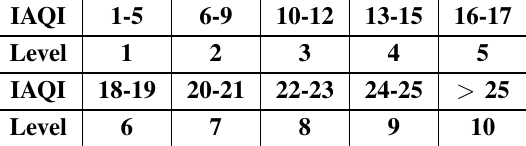
TABLE I P OLLUTION S PLITTING L EVELS FOR G ROUP PM2.5.